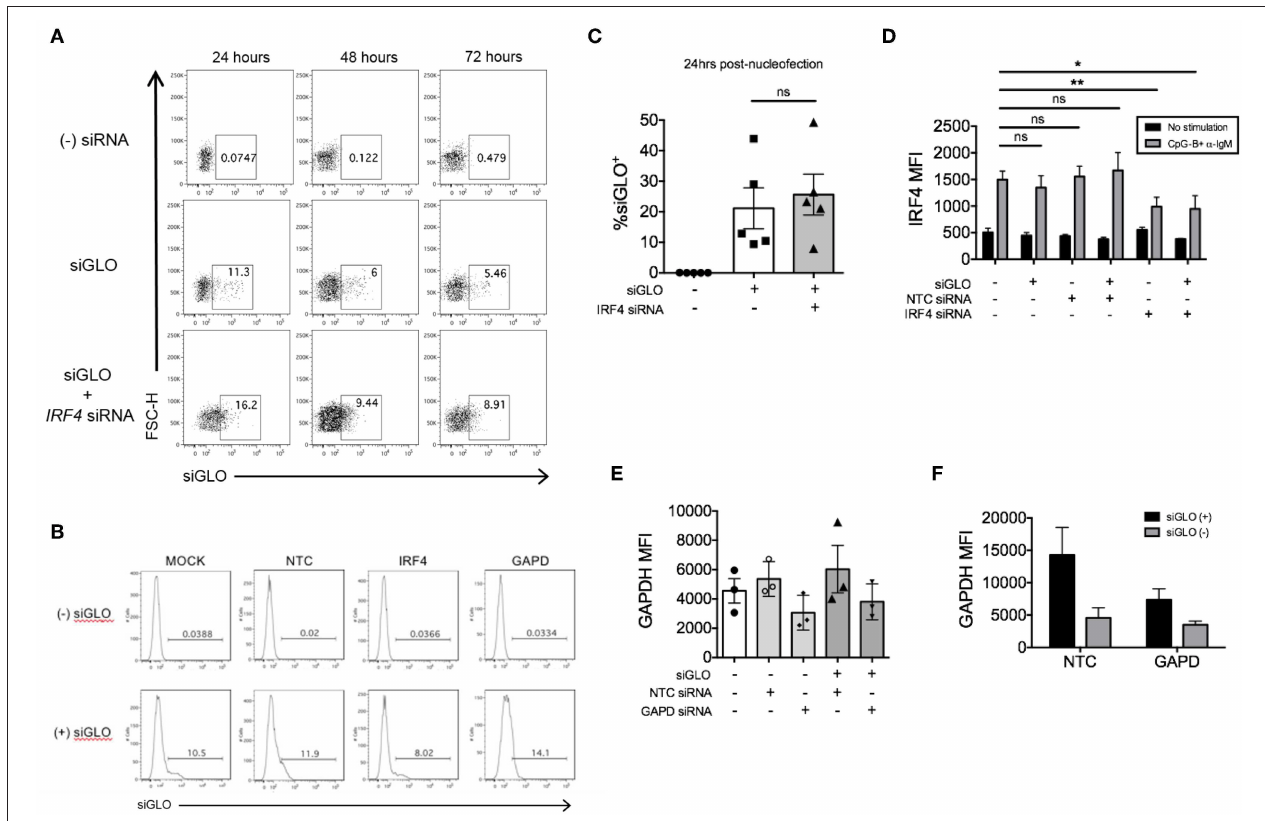
FIGURE 6 | siGLO green nucleofection of purified primary naïve B is transient and lost by 48h post-nucleofection. (A) Representative dot plots showing purified naïve B cells nucleofected with 1.5 µ M siGLO or 1.5 µ M siGLO + 1.5 µ M IRF4 siRNA cultured for 24, 48, and 72h after nucleofection and analyzed for siGLO + cells. (B) Similar to (A) except representative histograms show the different siGLO co-nucleofection efficiencies in naïve B cells at 24h post-nucleofection. (C) % siGLO + B cells are shown from multiple independent experiments of (B) at 24h post-nucleofection ( n = 5). (D) IRF4 knockdown effect is retained in naïve B cells co-nucleofected with siGLO and IRF4 siRNA after stimulation with anti-IgM + CpG-B for 48h ( n = 4). (E) Same as (D) except GAPD MFI was examined 24h post-nucleofection ( n = 3). (F) Comparison of GAPD knockdown from (E) in siGLO + vs. siGLO − cells. Bars represent mean ± SEM. P -values were determined by paired t -test for significance (* p < 0.05, ** p <